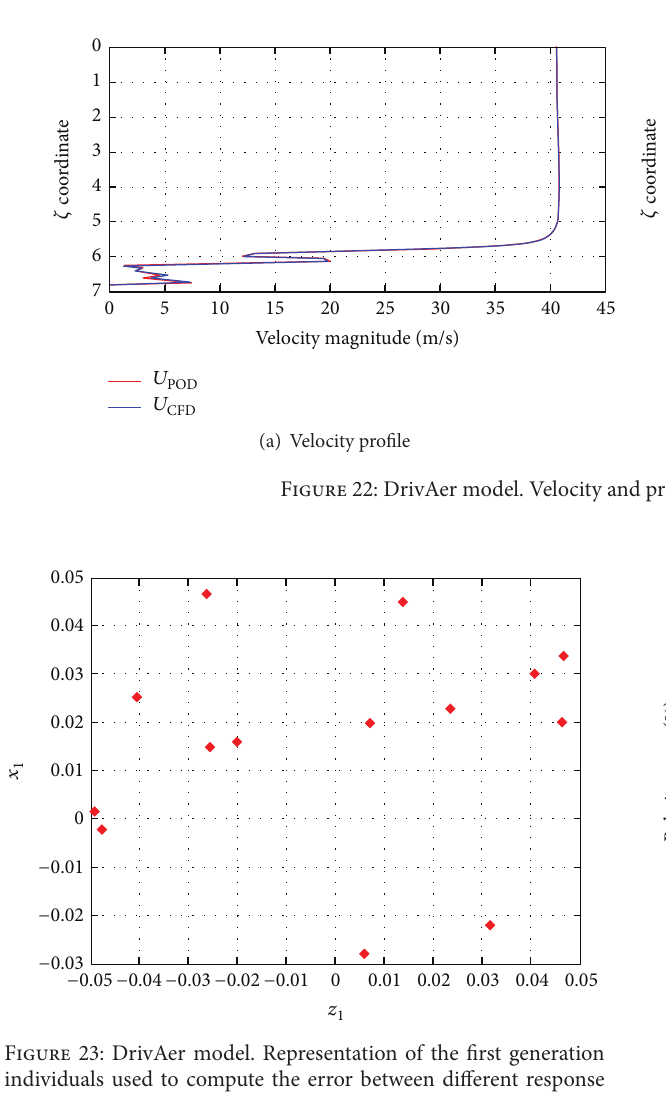
Figure 24: DrivAer model. Relative errors on the drag coefficient 𝑐 𝑥 using different RBF